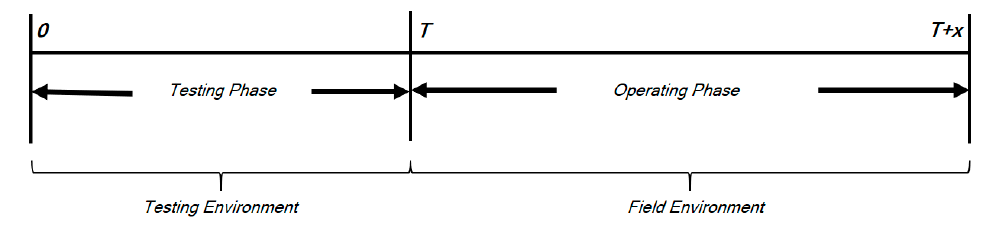
Figure 1. Basic infrastructure of the software cost model.